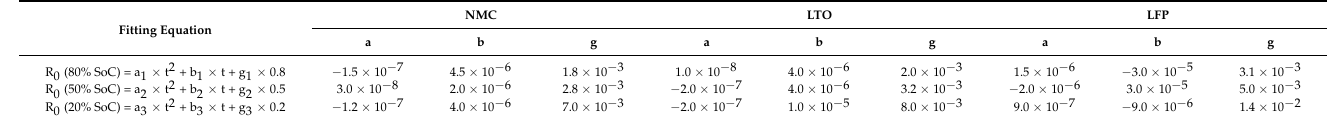
Table 3. Fitting coefficient of Equation (2).